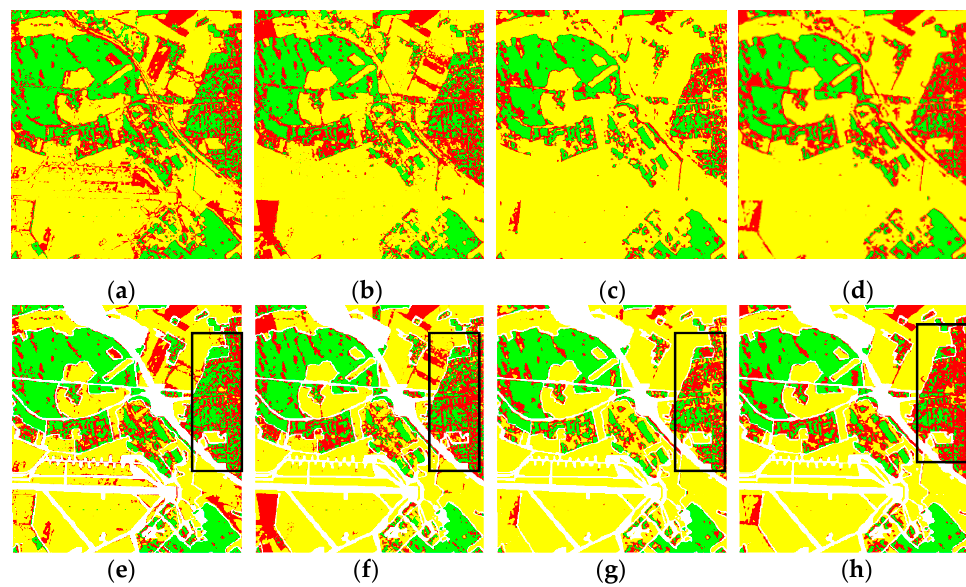
Table 3. Classification precision for the Oberpfaffenhofen dataset (%).